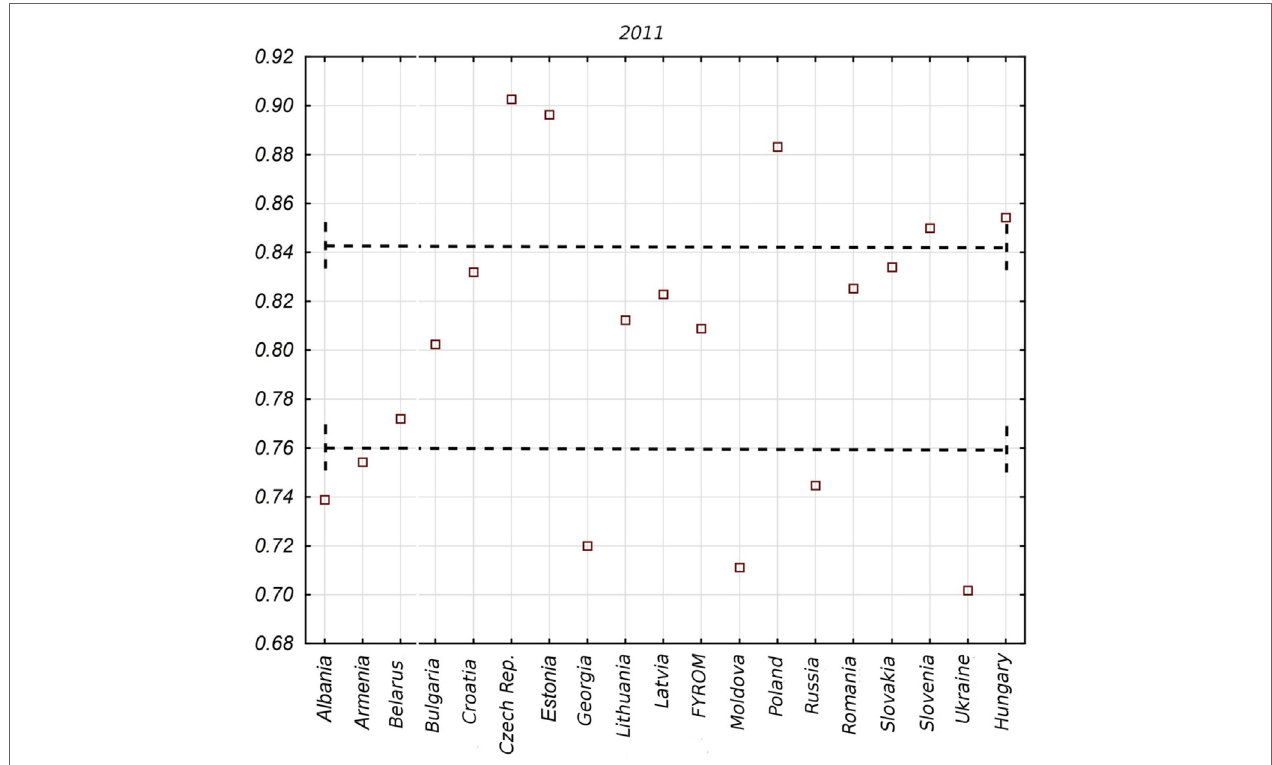
FIGURe 2 | Synthetic outcome measure values in post-communist countries in